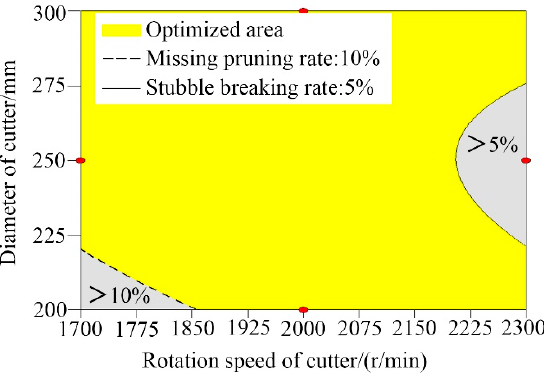
Figure 15. Coverage graph of optimization for response objective function.